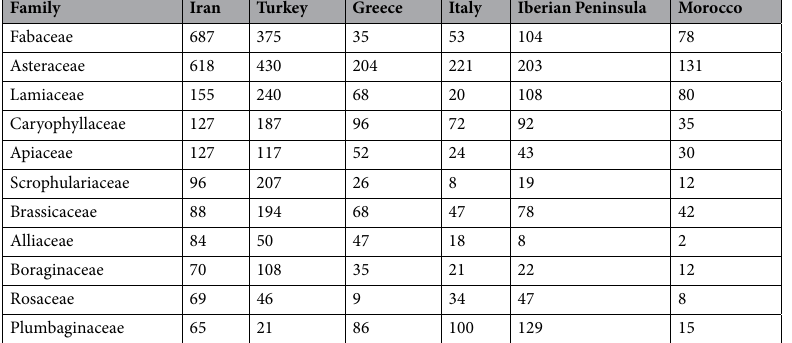
Table 3. The eleven most endemic-rich families in the vascular flora of Iran and other Mediterranean regions (Turkey, Greece, Italy, Iberian Peninsula, Morocco; data from Buira, et al . 40 ).